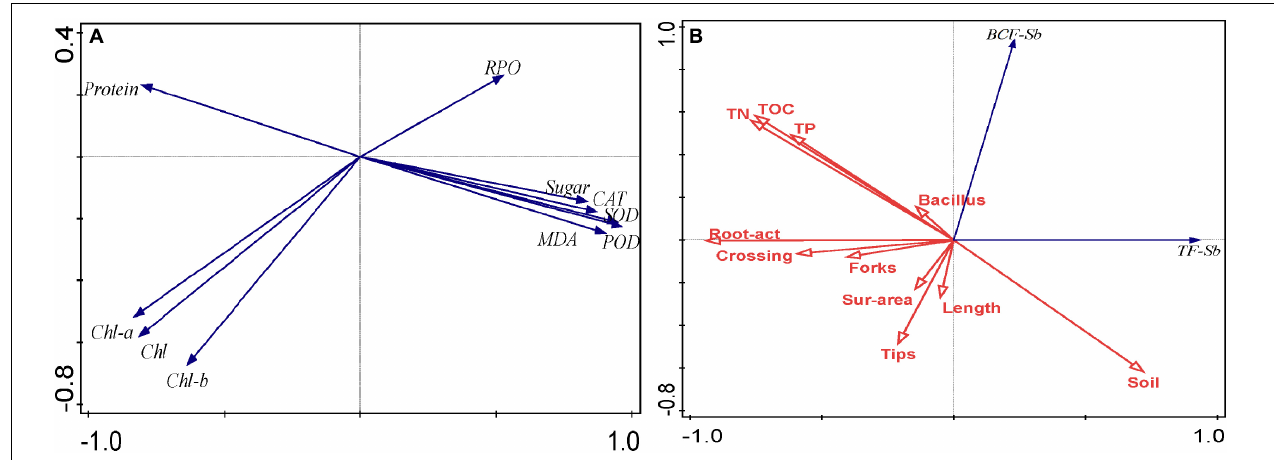
FIGURE 5 | (A) PCA of the content of MDA, PRO, sugar, protein, chl a, chl b, total chl, and the activity of SOD, POD, and CAT; (B) PCA of TF, BCF, root structure, root activity, soil nutrients content, and Bacillus